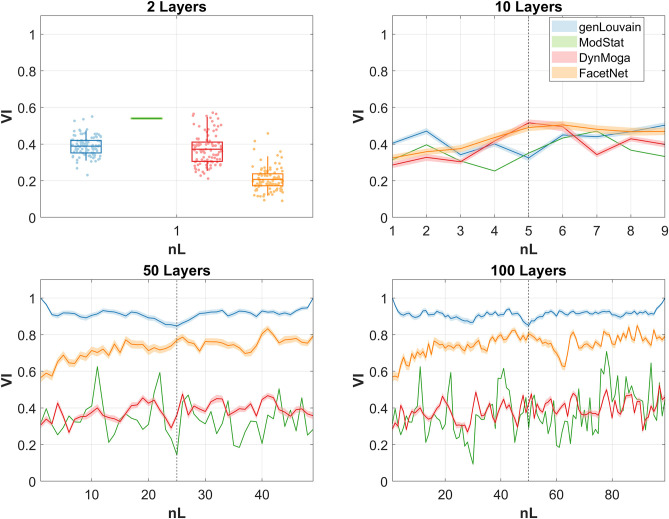
Normalized mutual information (NMI) computed between the output of the algorithms, identified with a color code, at consecutive layers of the multilayer network. As we run the algorithms 100 times, we report the means of the NMI at each snapshot, bounded by the confidence interval, represented with a lighter color. Each graph corresponds to one of the four networks extracted with different numbers of layers.